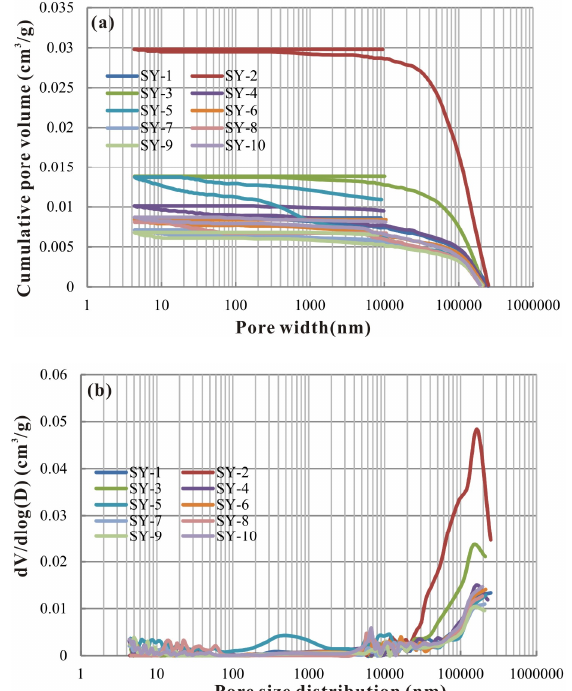
Figure 4. ( a ) The relationships between mercury injection/ejection and pore width, and ( b ) the pore size distribution of the shale samples using mercury injection data and the Washburn equation.